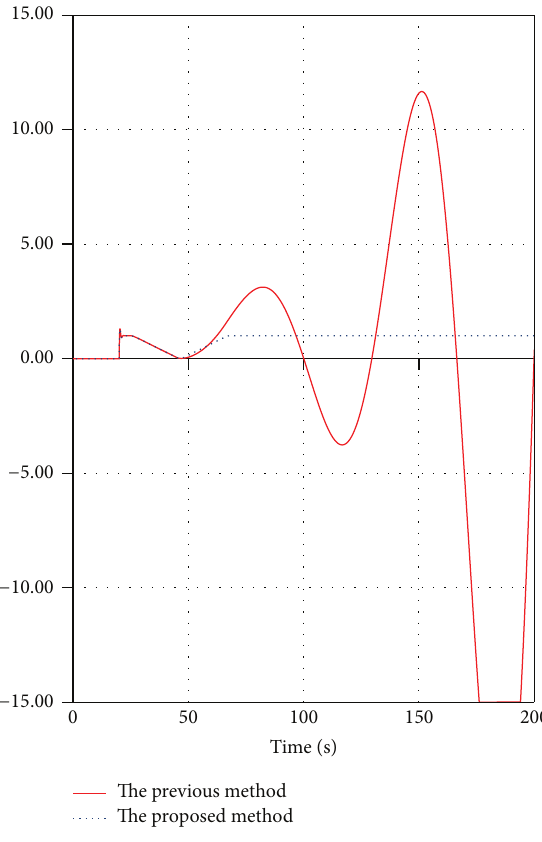
Figure 4: Simulation results for the plant with the dead time 20 (s).